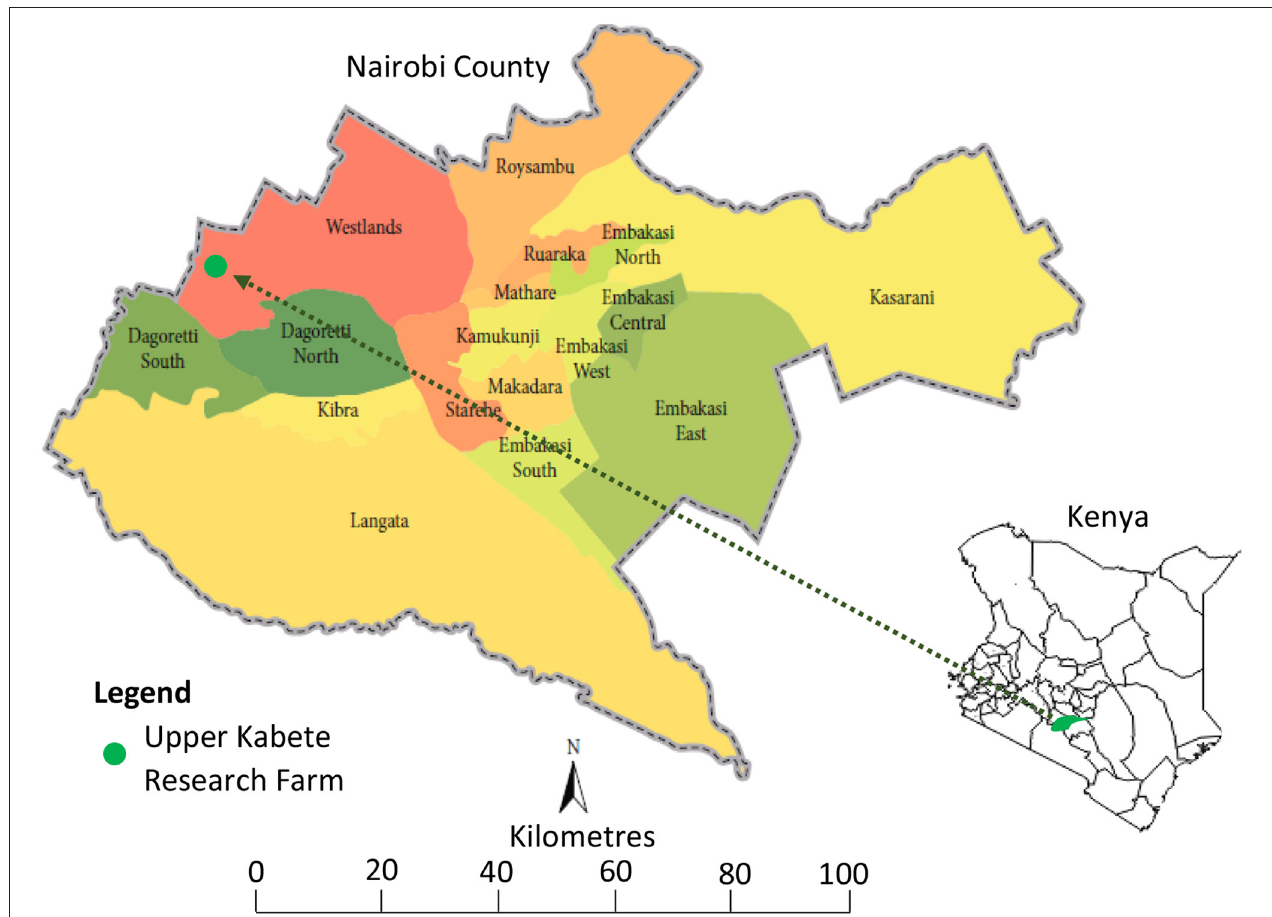
FIGURE 1 | Site map.